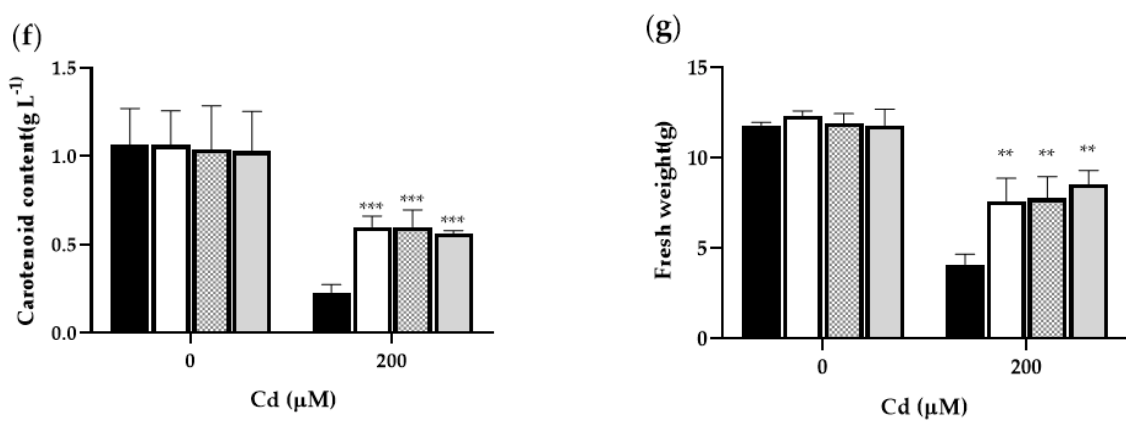
Figure 3. Effects of Cd stress in transgenic and WT plants. ( a ) Root phenotype of the WT and transgenic lines under 0 µ M Cd 2+ . ( b ) Root phenotype of the WT and transgenic lines under 200 µ M Cd 2+ . ( c ) Leaf phenotype in the WT and transgenic lines under 0 or 200 µ M Cd 2+ . ( d ) Chlorophyll a content in WT and transgenic plants. ( e ) Chlorophyll b content in WT and transgenic plants. ( f ) Carotenoid content of the WT and transgenic plants. ( g ) Fresh weight of the WT and transgenic plants. Data represent the means ± SD ( n = 3). WT: Wild-type tobacco. OE9, OE11, and OE12: Homozygous transgenic tobacco lines (T 2 ). The 4-week-old transgenic lines and WT plants were grown in Hoagland nutrient solution containing 0 or 200 µ M Cd for 7 d. Asterisks indicate a significant difference between the transgenic lines and the WT (*, p < 0.05; **, p < 0.01; ***, p < 0.001).